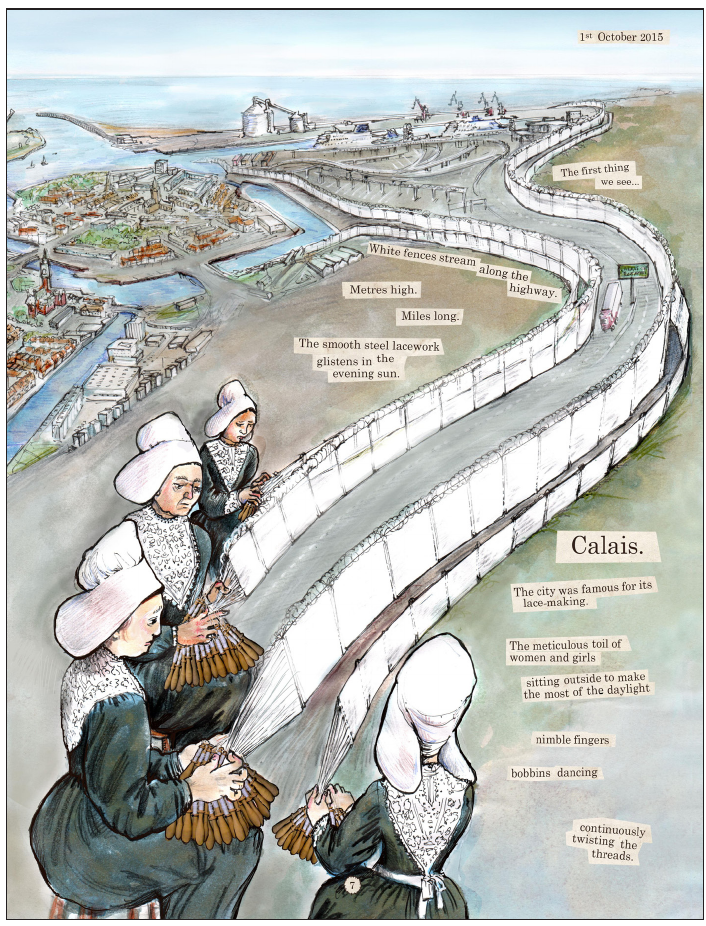
Figure 2: Kate Evans (2017) Threads from the Refugee Crisis (New York: Verso, 7). © Verso New York. Image presented with permission of Kate Evans and